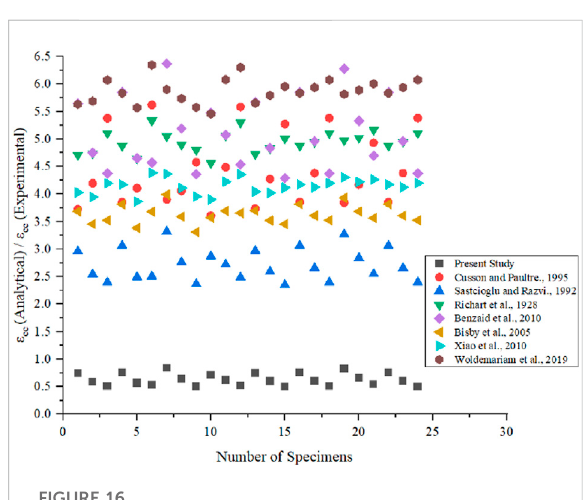
FIGURE 15 Predicted models for peak stress estimation without the longitudinal reinforcement.